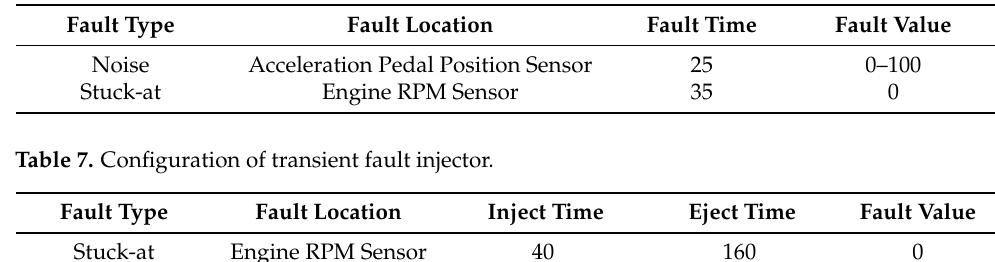
Table 6. Configuration of permanent simultaneous fault injector.